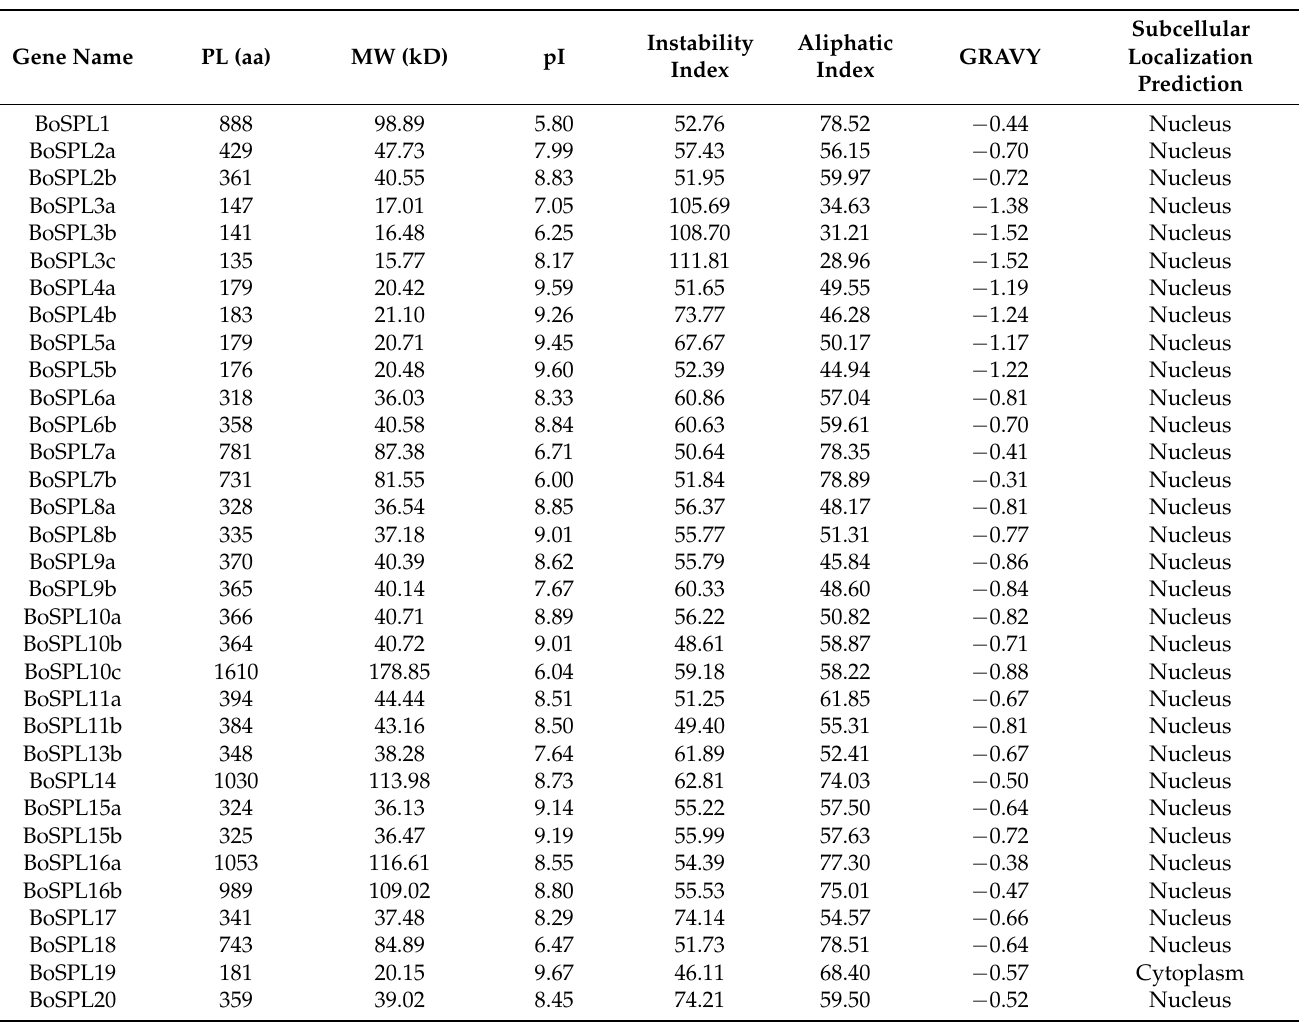
Table 1. SPL family genes in Brassica oleracea